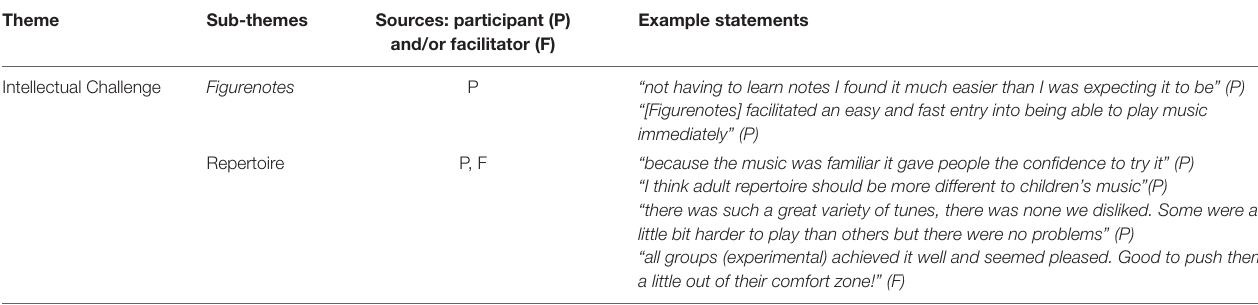
TABLE 4 | Sub-themes and example statements from themes of Lessons and Practice .